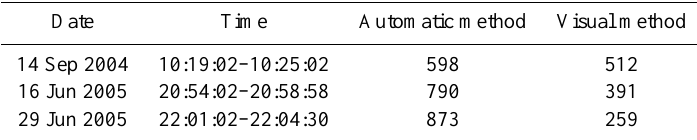
Table 1. Number of whistlers detected by automatic method and by manual method.